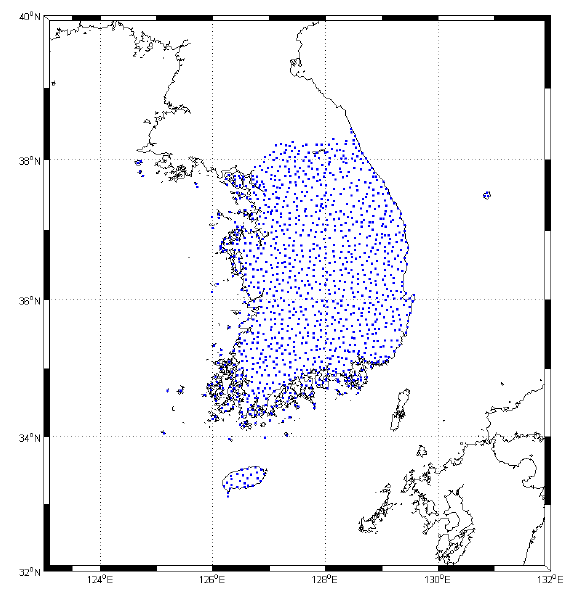
Figure 1. Distribution of a total of 1175 points of the GPS/levelling data (blue